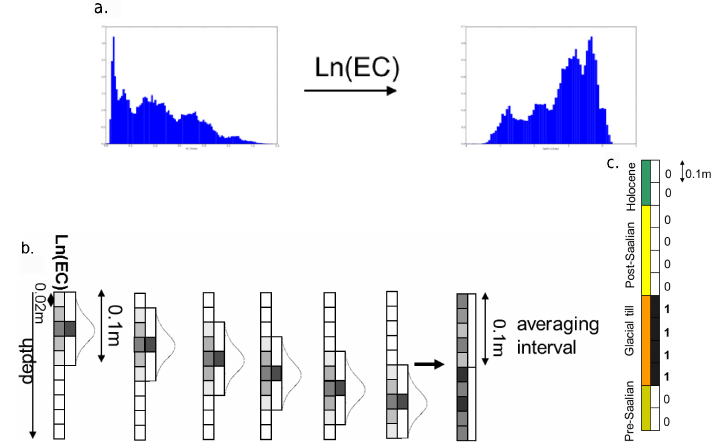
Fig. 13. Data pre-processing for training the